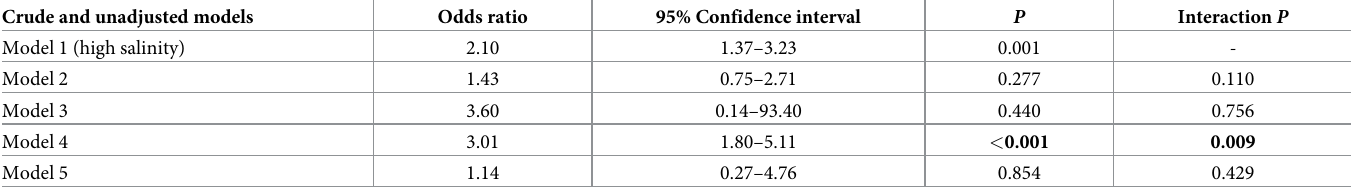
Table 4. Crude and adjusted odds ratios of hypertension by high groundwater salinity and interactions with other potential covariates (total n = 356; non-exposed 205; and exposed 151). Crude and unadjusted